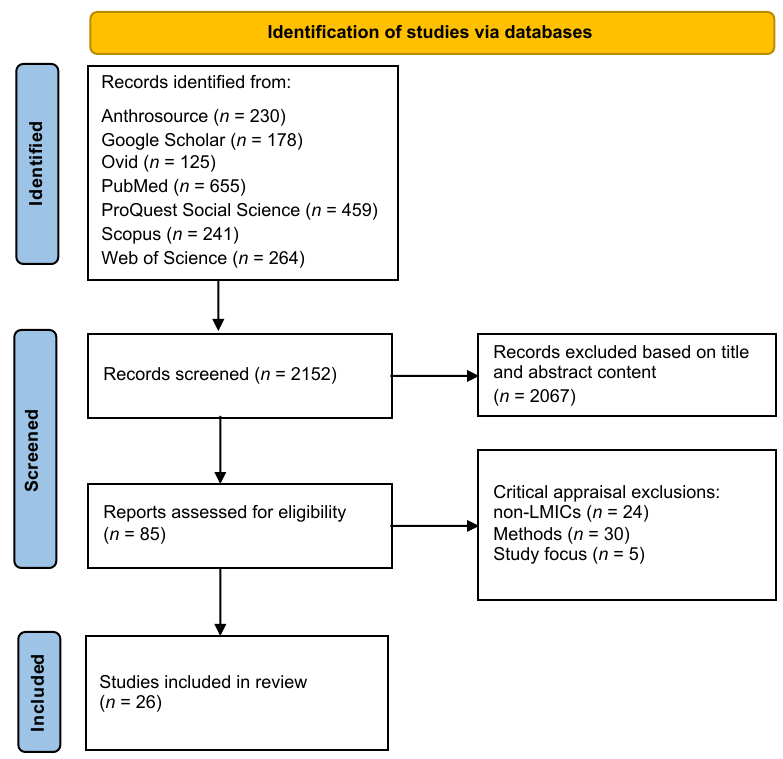
Figure 1. PRISMA flow diagram of the study selection